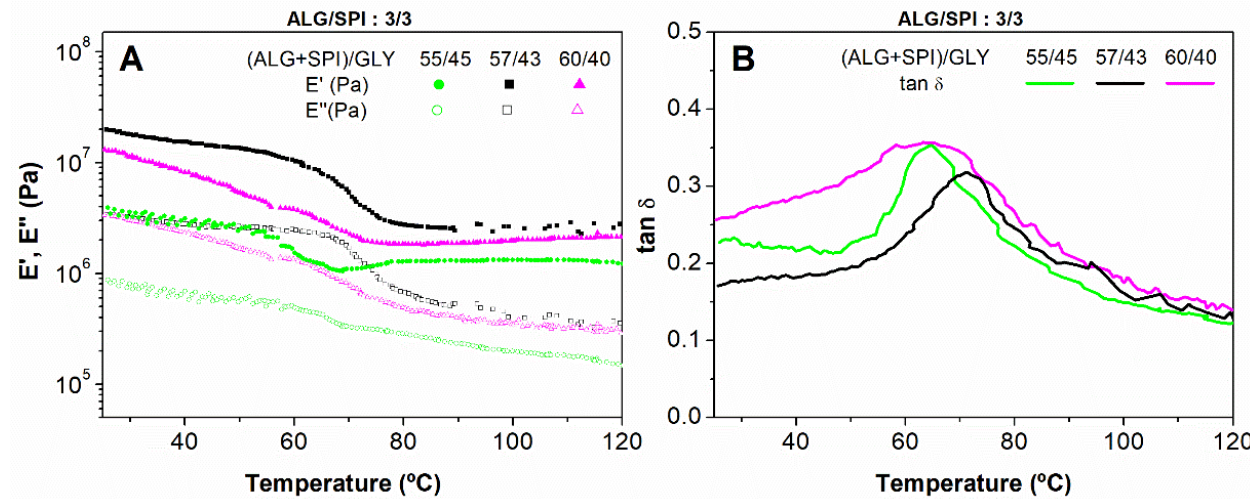
Figure 3. Evolution of the viscoelastic moduli ( A ) and loss tangent ( B ) with temperatures for alginate + soy protein isolate/glycerol blends with different ratios: 55/45, 57/43, and 60/40, maintaining the ALG/SPI ratio of 3/3.